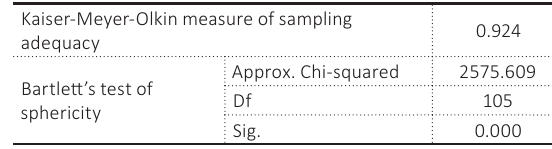
Table 7. KMO and Bartlett’s test